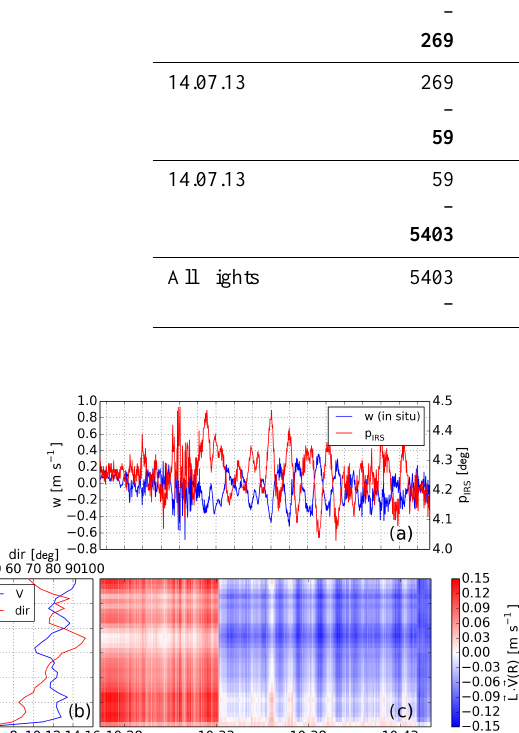
tion of the horizontal wind speed and direction obtained from a previous measurement leg (10:00 to 10:15 LT) was used (Fig. 2b). The resulting projection L × V (R) is shown in Fig. 2c. Finally, the vertical wind speed can be determined sub- tracting the aircraft speed and horizontal wind speed projec- tions from the relative speed measured by the DWL. The